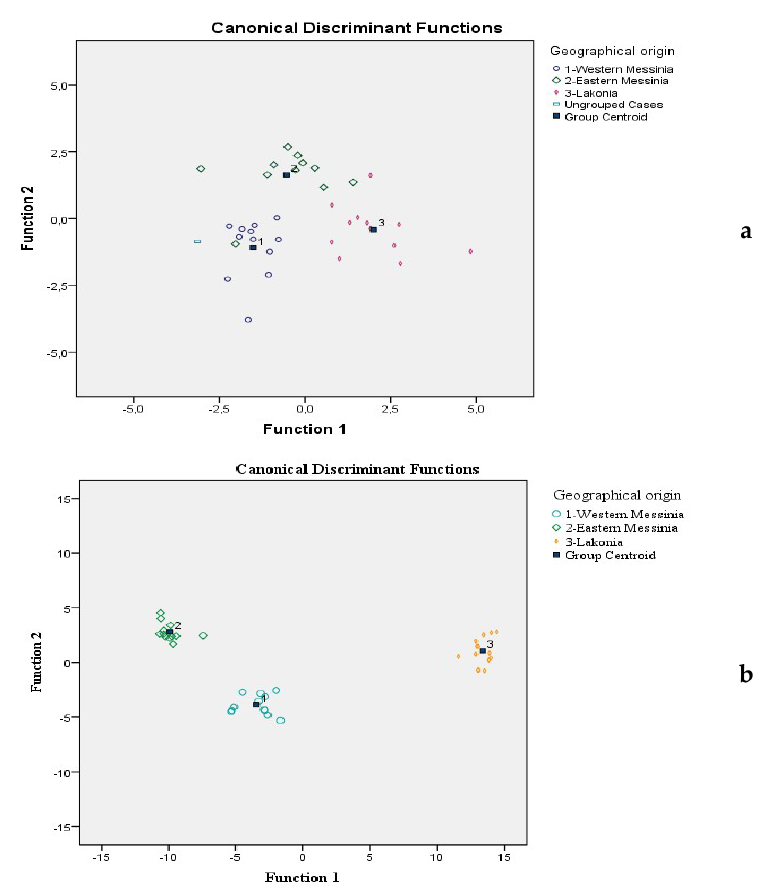
Figure 2. ( a ) Classification of prickly pear juice according to geographical origin based on 7 minerals and linear discriminant analysis (LDA). ( b ) Classification of prickly pear juice according to geographical origin based on 21 volatile compounds and LDA.